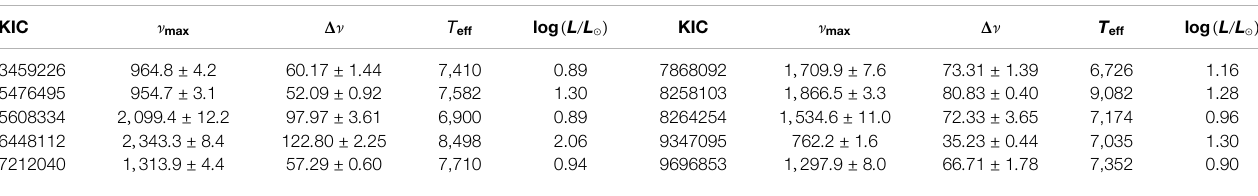
TABLE 3 | Stars discussed in the text with possible solar-like oscillations. The columns are the same as in Table 1 .